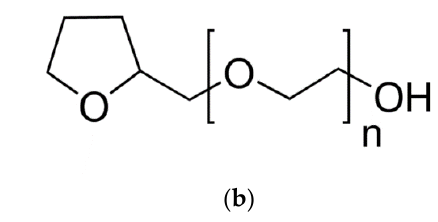
Figure 1. Structural formulas of ( a ) PLGA (x = 0.75, y = 0.25) and ( b ) ( n = 3).